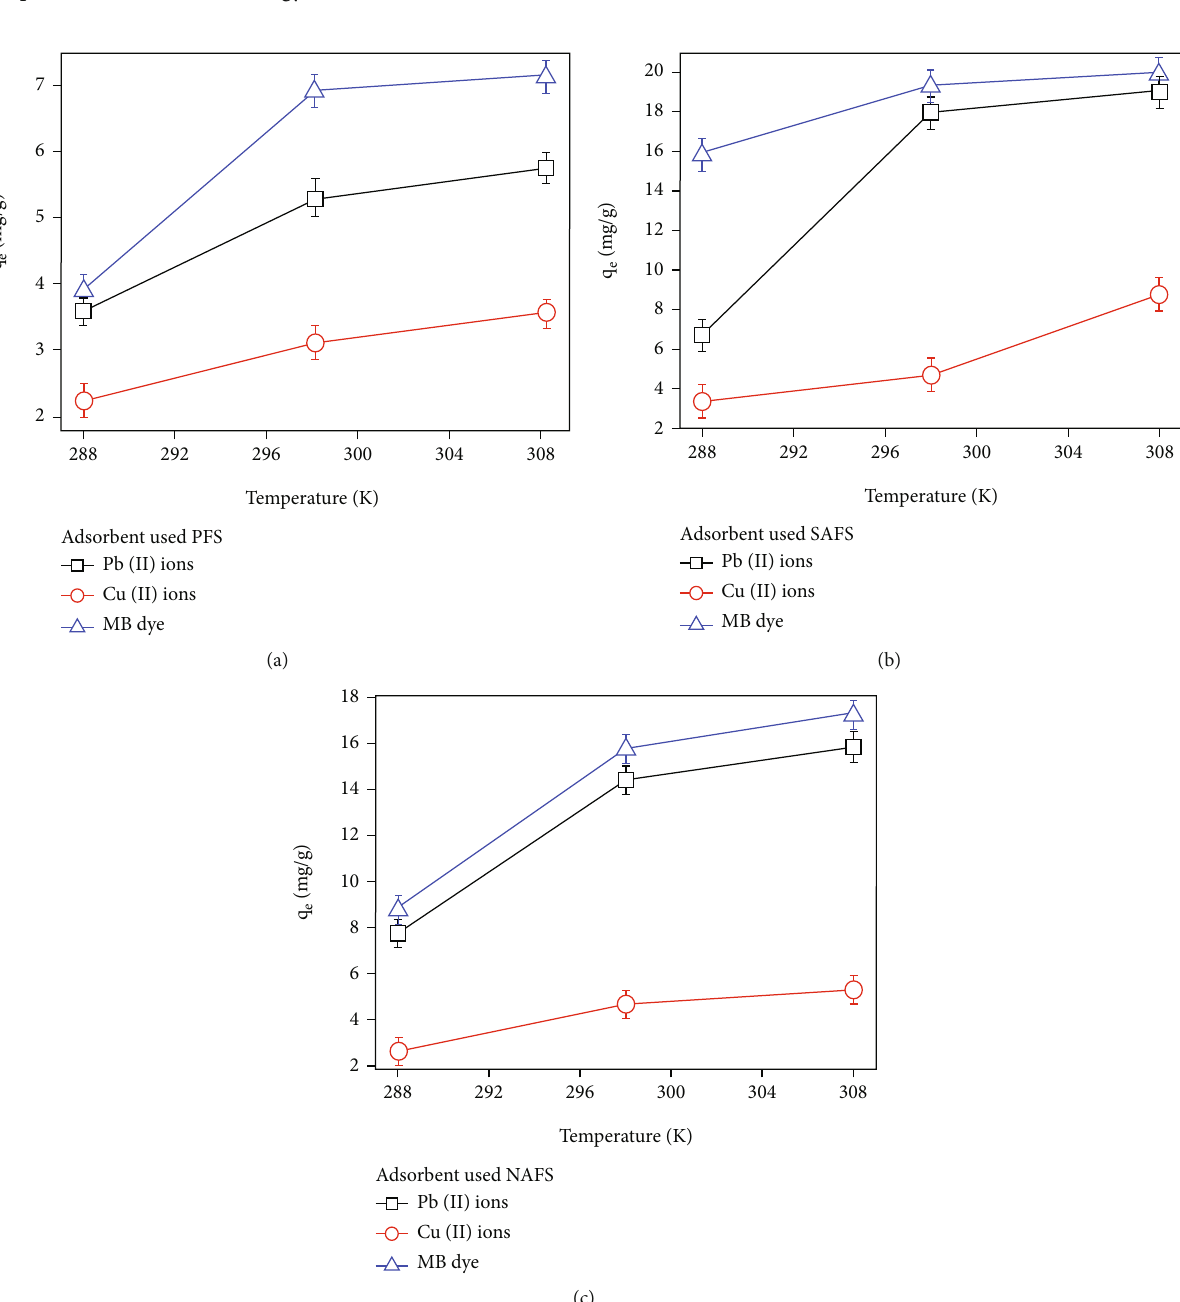
Figure 7: Temperature e ff ect studies on the adsorption of Pb(II), Cu(II), and MB onto pure (a) PFS and treated (b) SAFS and (c) NAFS fennel seed adsorbents (system parameters: workingsolution = 100mg/L temperature = 298 K, pH = 7, contacttime = 120 min, andadsorbent mass = 10mg